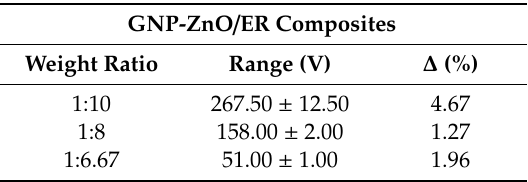
Table 2. Switching threshold voltage of GNP-ZnO / ER specimens filled with various weight ratios of GO to Zn(Ac) 2